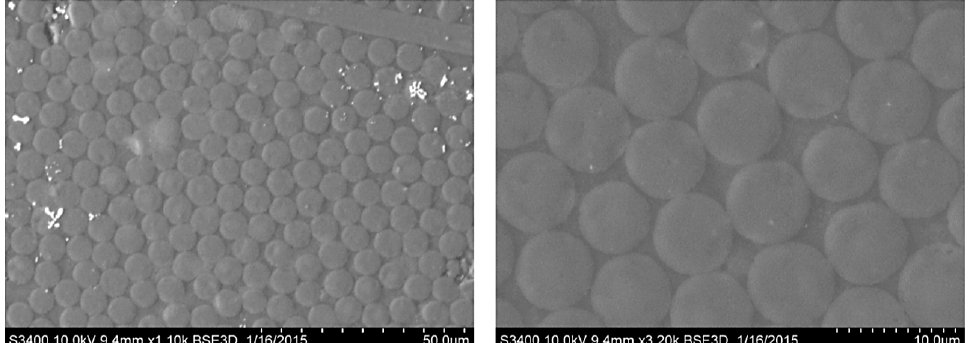
Figure 12. CFRP composite microstructure photomicrographs; magnification of 1100 × and 3200 × for sample 5.